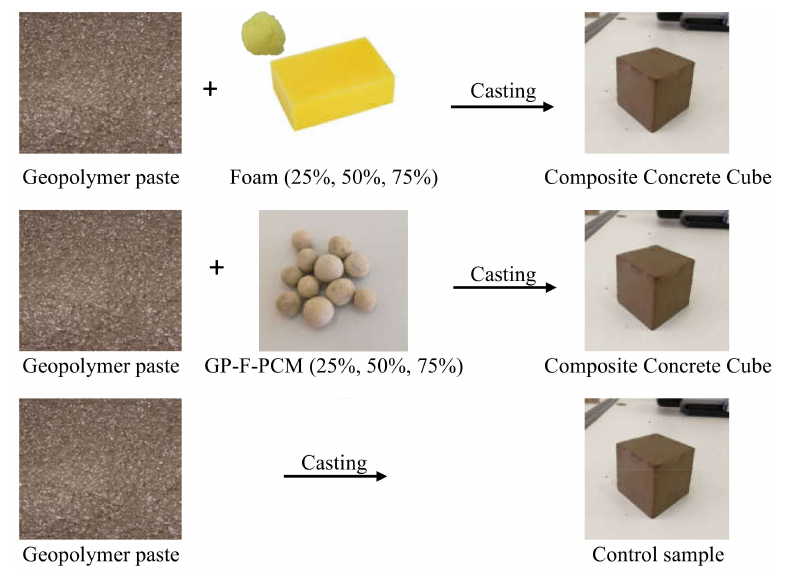
Figure 2. Representation of the development of concrete cubes. Table 1. Geopolymer composition (mass ratio, kg/m 3 ).